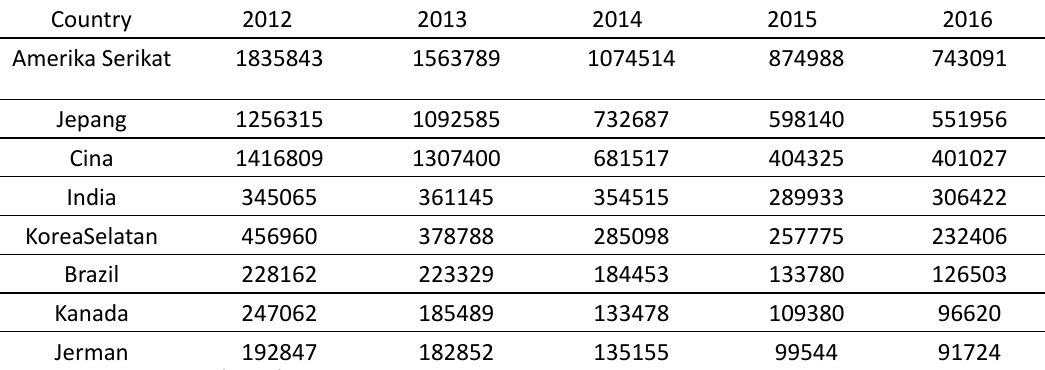
Table 1: Export Indonesian Natural Rubber to Main Destination Countries, 2012-2016 (US